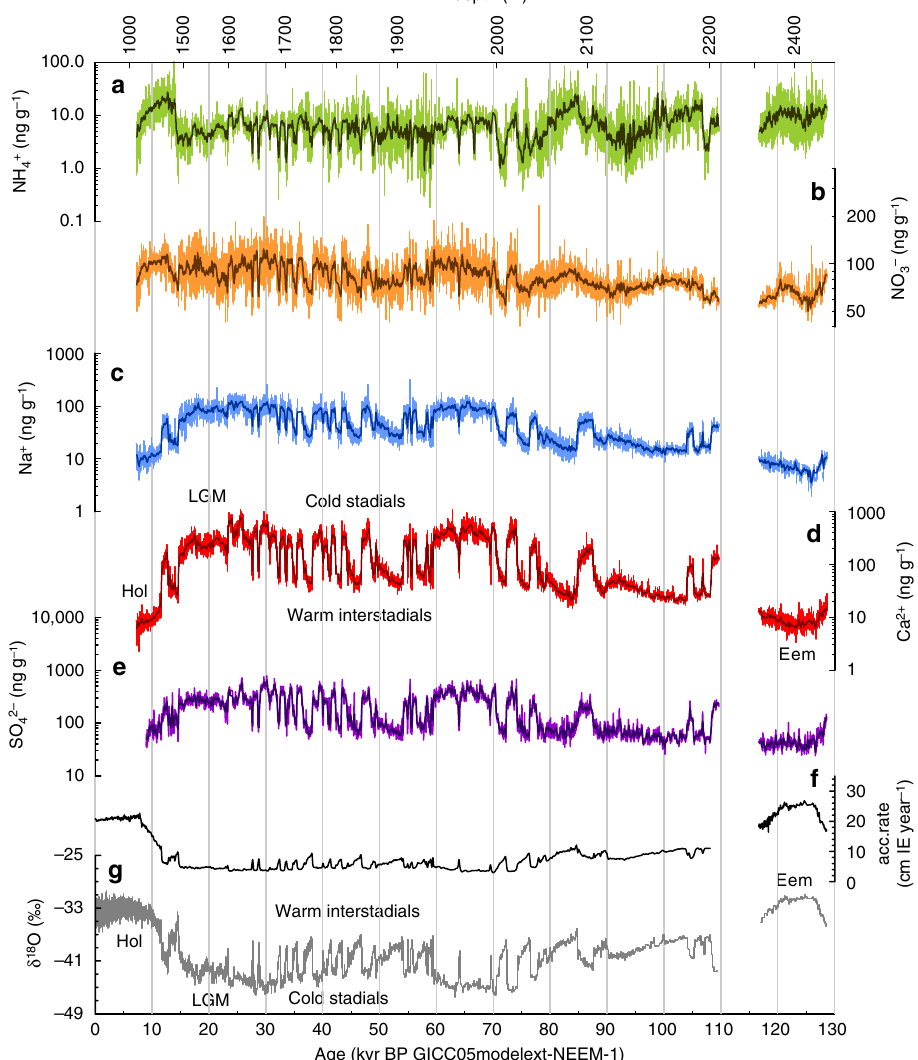
Fig. 1 Measured ion concentrations in the ice. Variations of the aerosol concentration records in the ice in 10-year resolution (light coloured lines) for a NH 4 + , b NO 3 − , c Na + , and d Ca 2 + (note the smaller logarithmic range of the NO 3 − axis). In the case of SO 4 2 − ( e ) the light thin line represents a fi ve point running mean of the 10 year data, representative of the maximum 40 year resolution that can be achieved with the SO 4 2 − data over the entire length of the record. The dark bold lines represent 21 point running means of the 10 year data. The record of the glacial inception is missing due to folding in the ice 4 . In addition, the accumulation rate (black line) is plotted in f for 0 – 108 kyr BP according to ref. 62 . For the Eemian interval the accumulation is based on an exponential fi t of the north west Greenland accumulation and δ 18 O relationship 54 . In g NEEM δ 18 O is shown as a grey line in 55 cm resolution for the time period 0 – 110 kyr BP and for the Eemian period 4 . All data are shown on the GICC05modelext-NEEM-1 age scale 62 in years